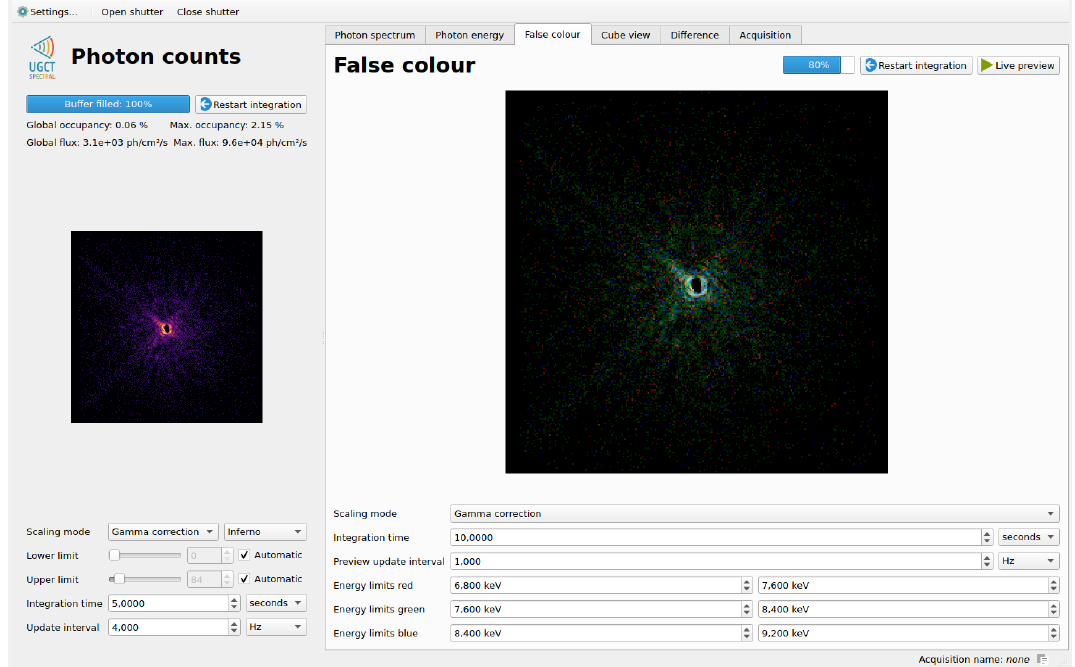
Figure 5. The main user interface used to control and monitor the SpeXIDAQ system. This example shows the pnCCD-based SLcam being used at a ptychography experiment at Diamond Light Source